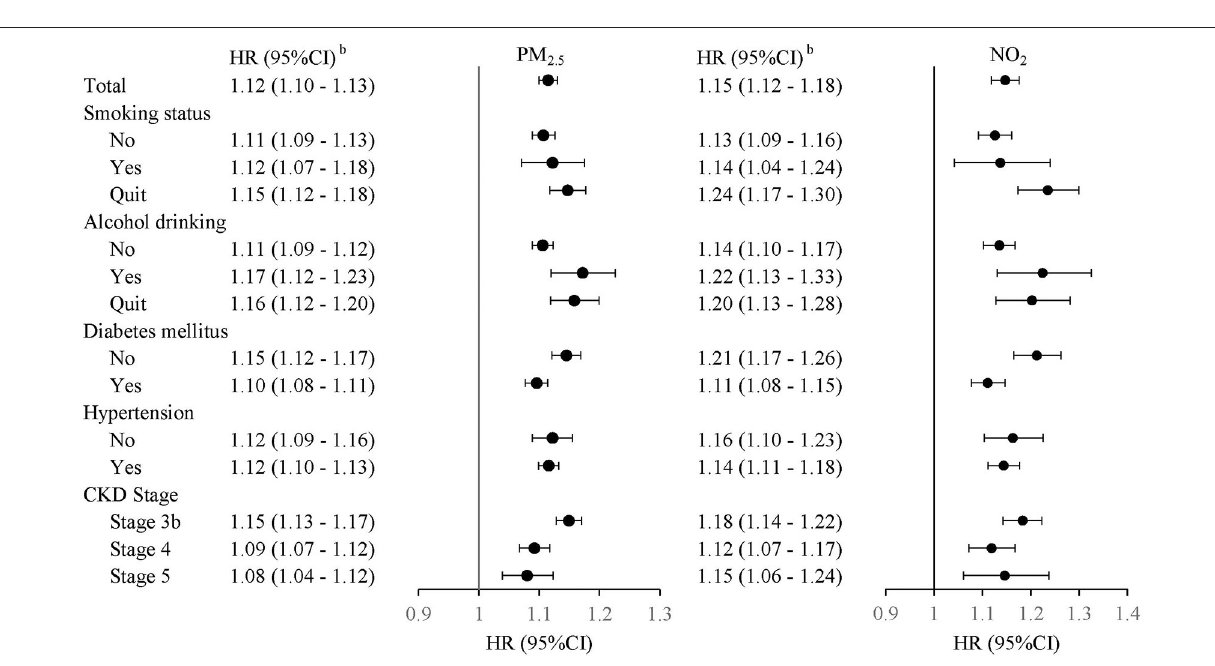
FIGURE 3 | Adjusted hazard ratio (HR) with 95% confidence interval (CI) (gray area) of eGFR deterioration with PM 2.5 and NO 2 stratified by smoking status, alcohol status, diabetes, hypertension, and CKD